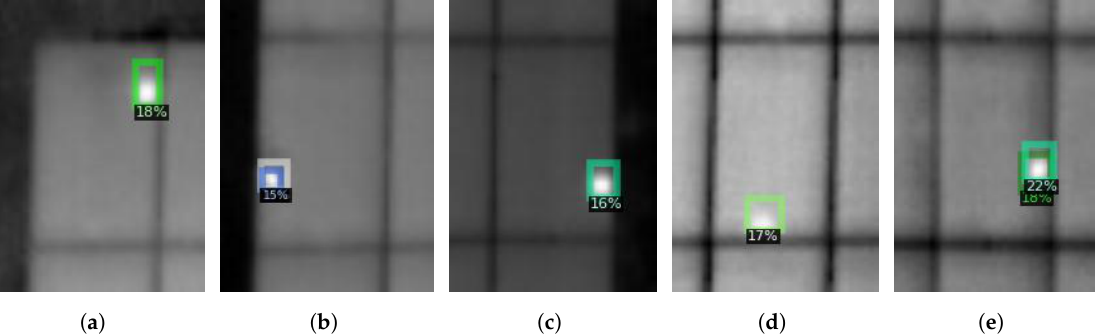
Figure 11. Five different hotspots ( a – e ) detected using our region-based CNN algorithm on the dataset acquired at Kumagaya, Japan.